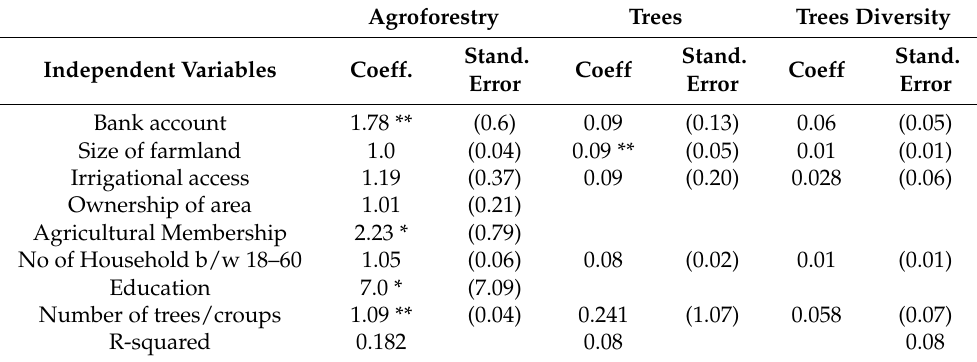
Agroforestry Trees Trees Diversity Stand. Stand. Stand. Coeff Coeff Error Error Error